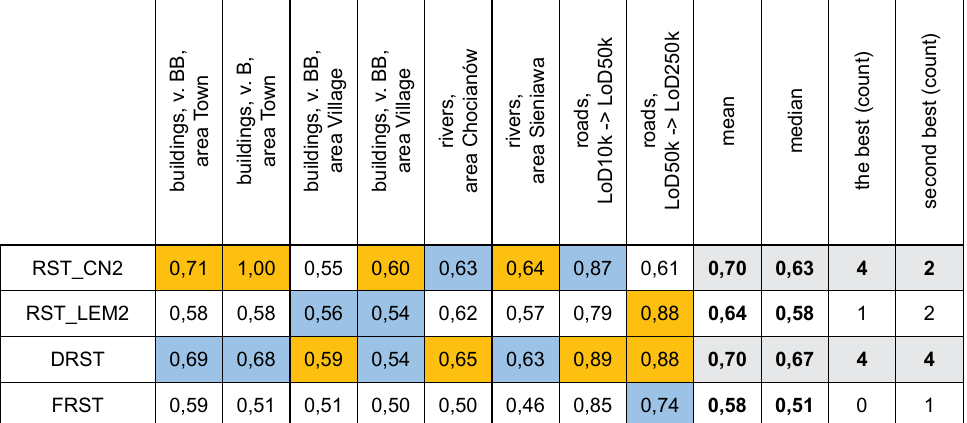
v s , ng d i bu il